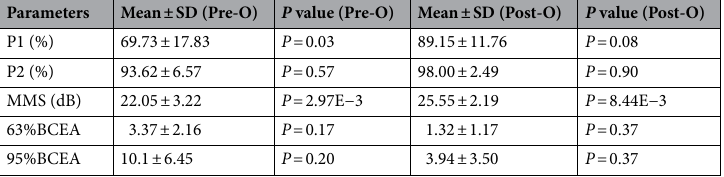
Table 2. Results of Spearman analyse between MAIA parameters and BCVA before and after surgery. P1 and P2 represent the number of fixating points which was in circles of 1° and 2°radius, respectively. MMS mean macular sensitivity, BCEA bivariate contour ellipse area, Pre-O preoperation, Post-O postoperation, SD standard deviation.